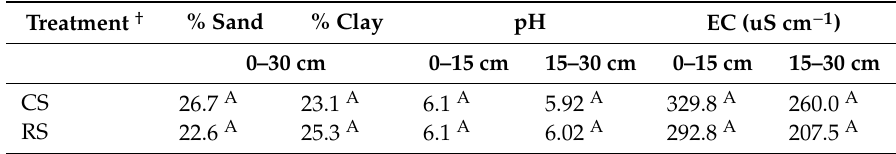
Table A1. Means of percent sand and clay and pH and electrical conductivity (EC) by layer for each treatment.